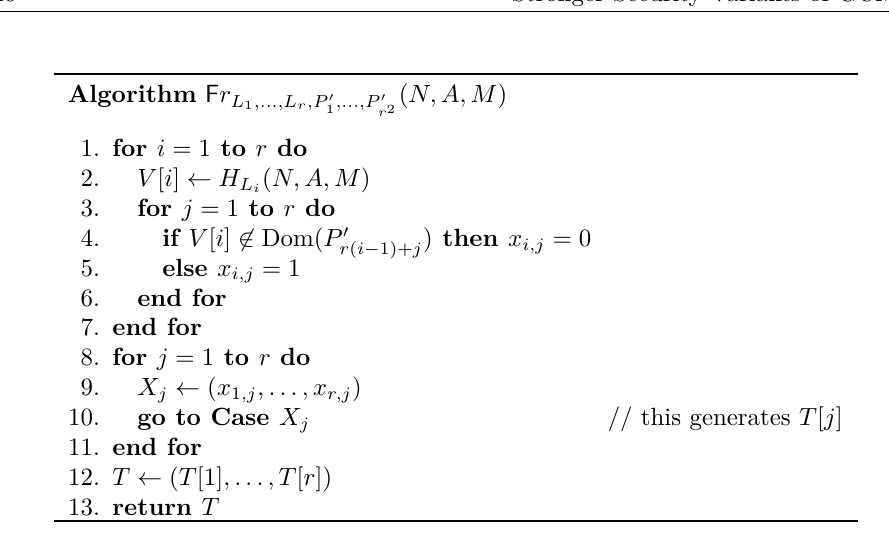
Figure 8: Main Game of F r , the PRF part of GCM-SIV